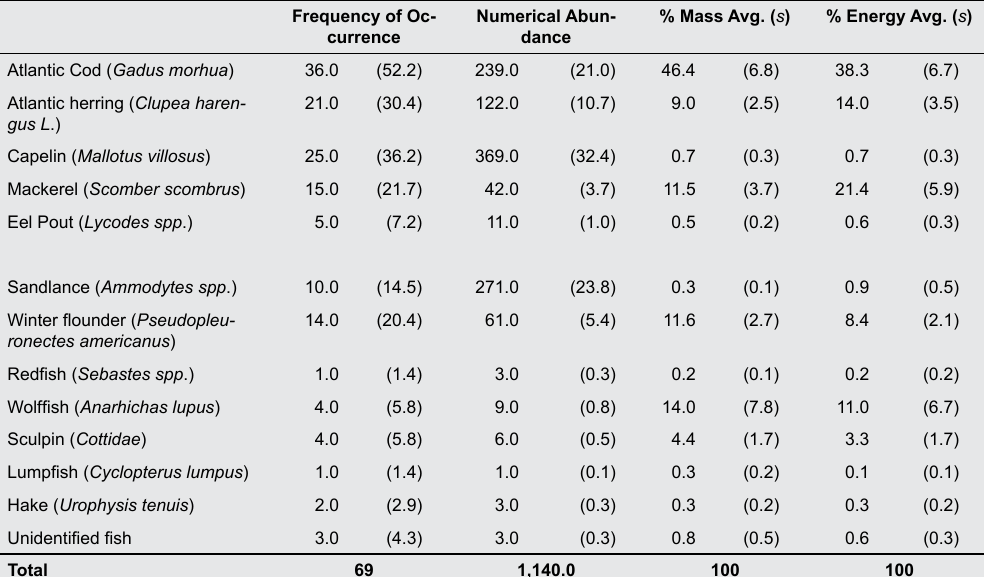
Table 4. Diet composition of 69 seals collected at Anticosti Island August-September 1992. Fre- quency of occurrence and % frequency of occurrence in parentheses, numerical abundance with relative percent in parentheses, and percent (%) mass and energy contribution to the diet with standard deviation in parentheses.